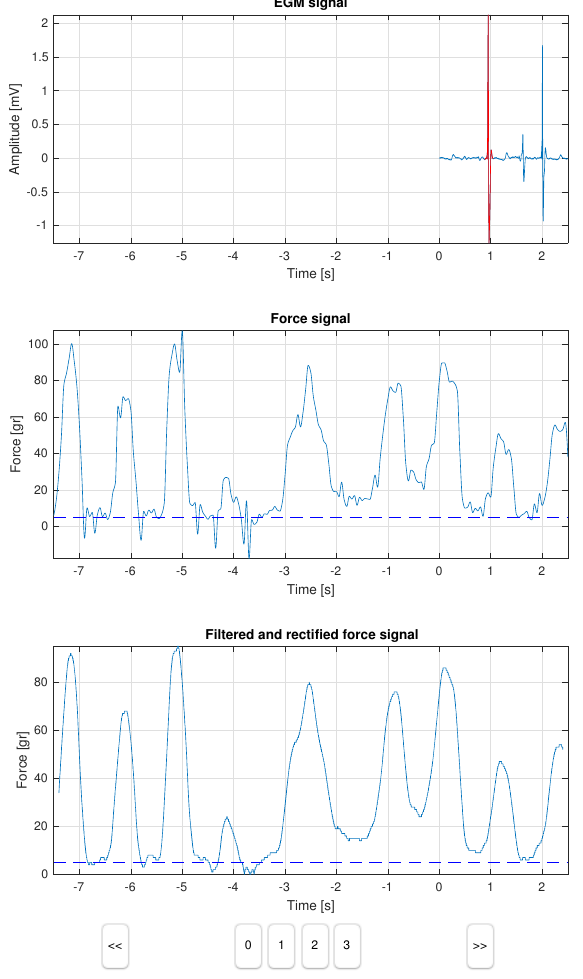
Figure 1. The computer tool dashboard displays the EGM signal, the simultaneously recorded force signal, its filtered and rectified version, and several selection and control